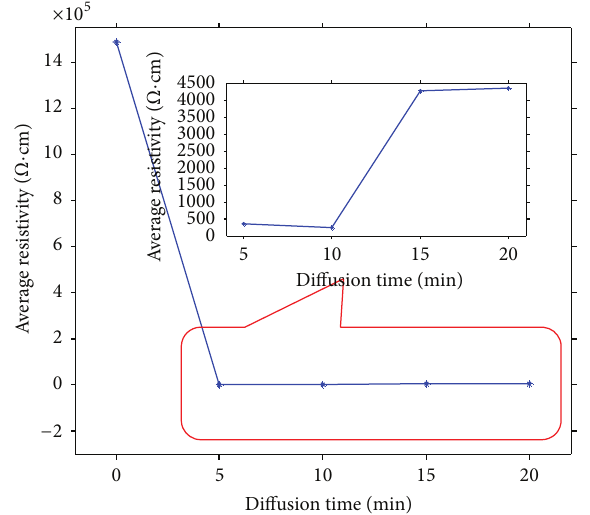
Figure 4: Average resistivity at different diffusion